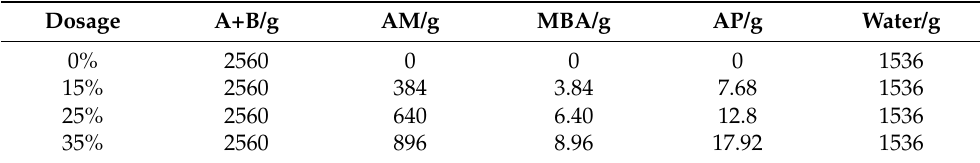
Table 4. The mix proportions for the organic